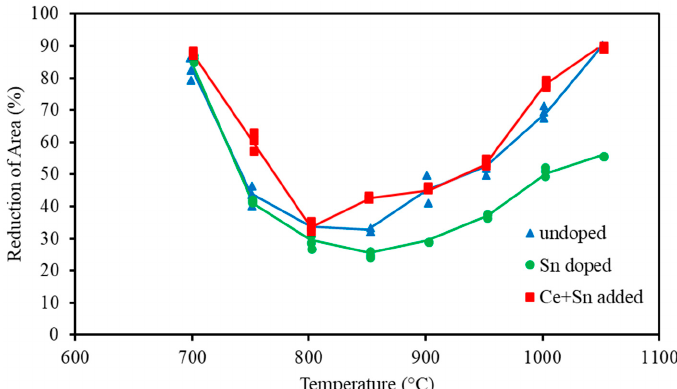
Figure 17. Hot ductility curves for 0.1% C, 1% Cr, 0.5 % Mo steels that were un-doped, doped with 0.055% Sn, and doped with 0.055% Sn and 0.05% Ce [22]. Adapted from [22], with permission from Elsevier, 2023.